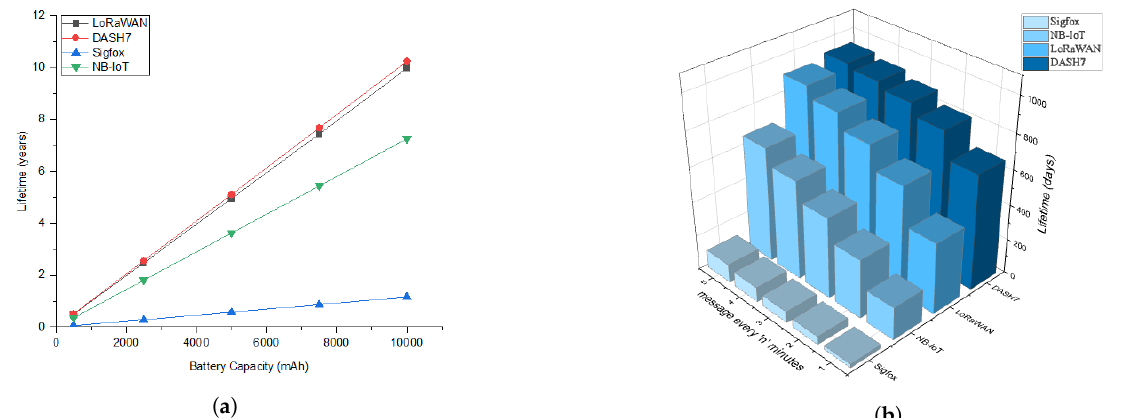
Figure 21. Lifetime estimation for different LPWAN technologies: ( a ) Different battery capacities; ( b ) Different frequency of message transmission (every 1,2,3,4,5 min with constant 2500 mAh battery). Table 7. Battery life estimation for LoRaWAN